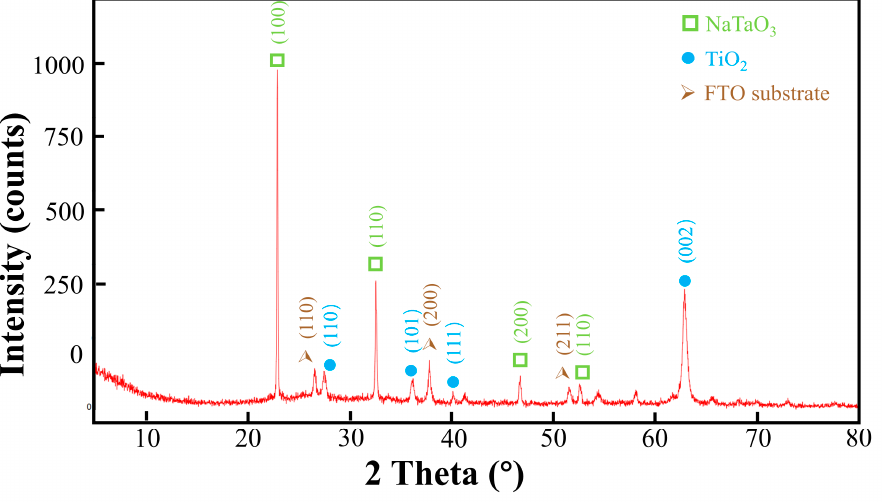
Figure 2. The XRD patterns of the composite film.